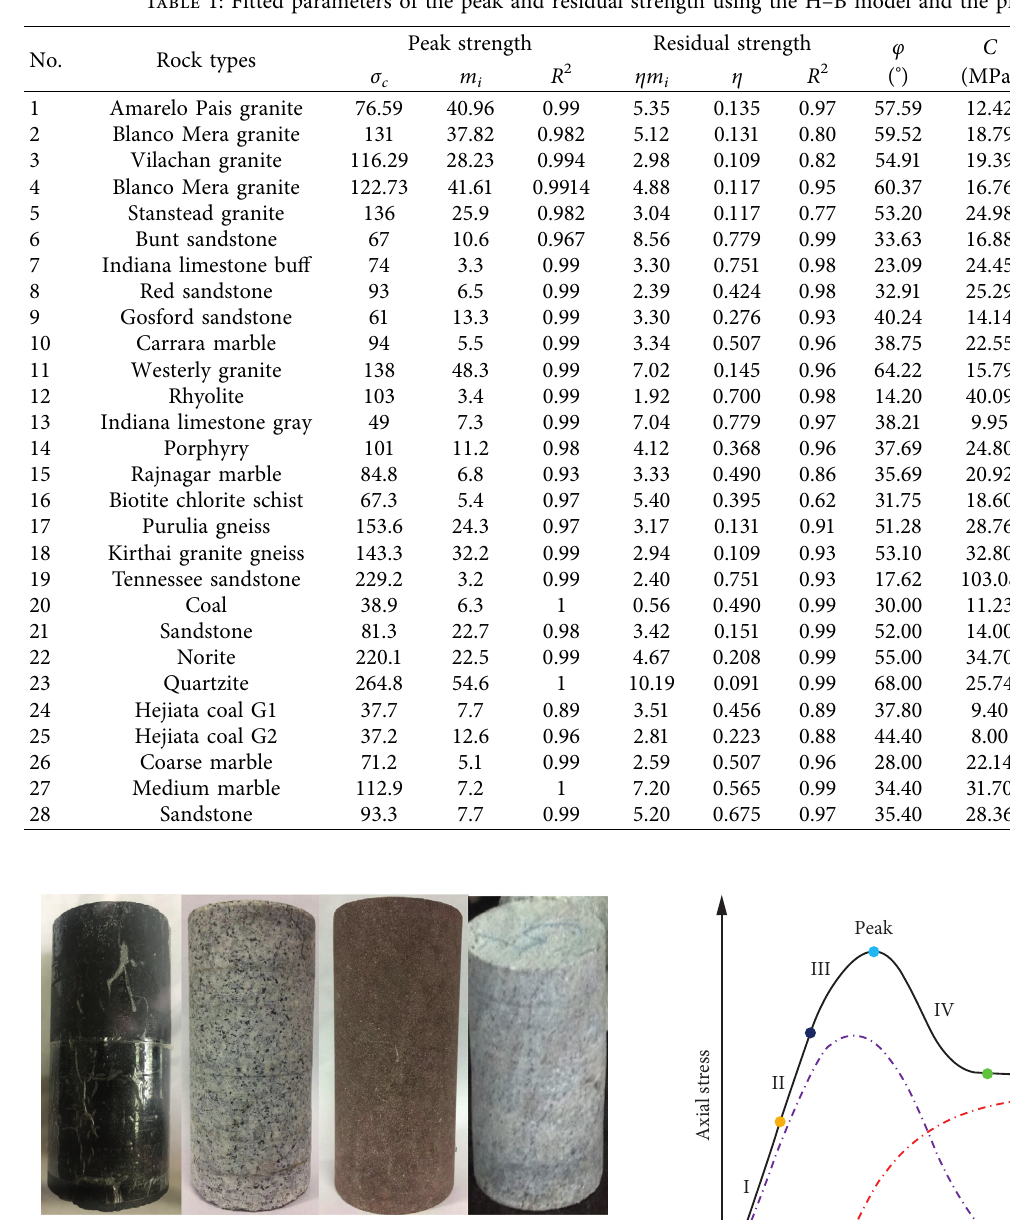
Figure 1: Rock types tested in the work (slate, granite, red sandstone, and limestone).